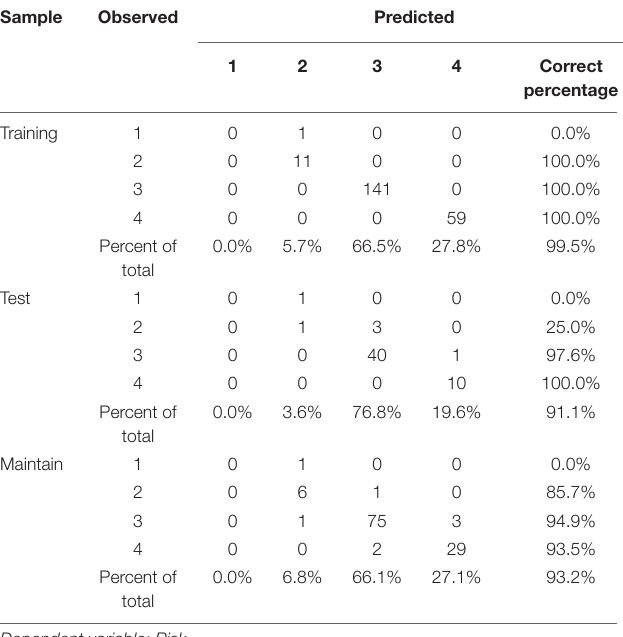
TABLE 3 | Classification and display table of training results of BP artificial neural network evaluation model.